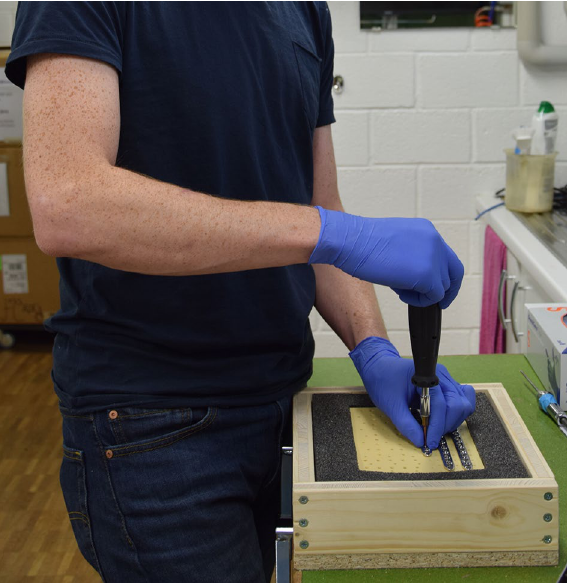
Figure 2. Demonstration of participant performing the screw insertion